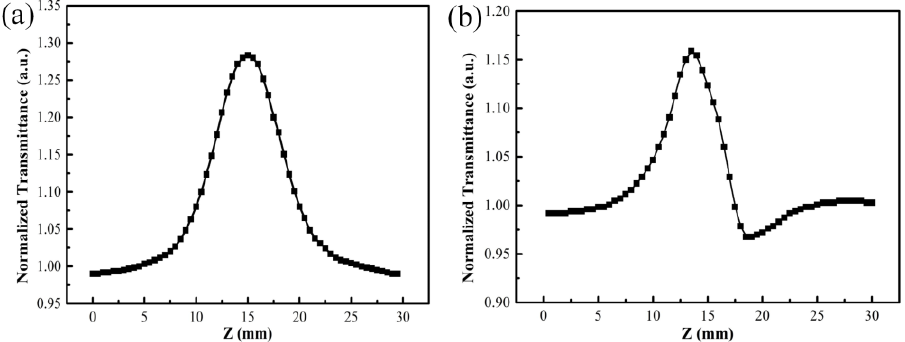
Figure 3. Open-aperture ( a ) and closed-aperture ( b ) Z-scan curves of V 2 O 5 thin film with thickness of 90 nm. of 90 nm.